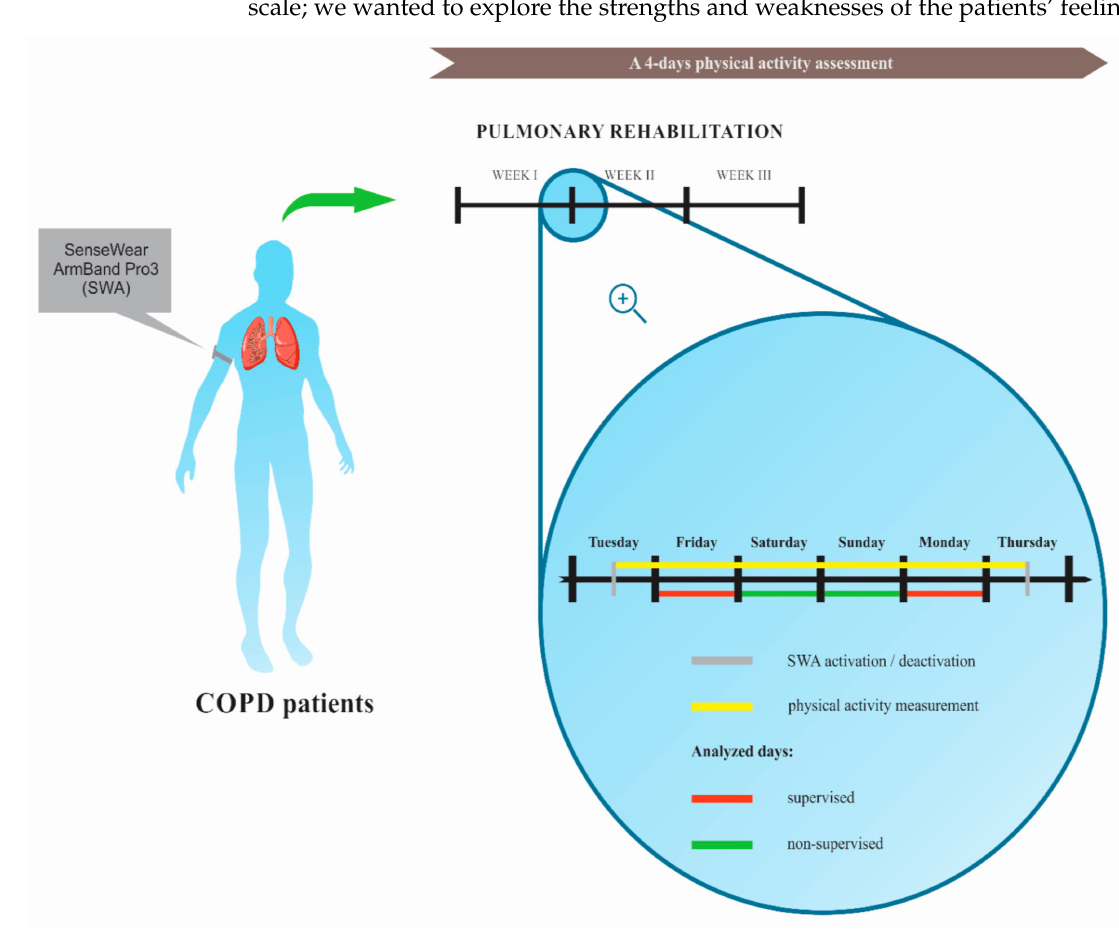
Figure 1. Study flow chart of physical activity